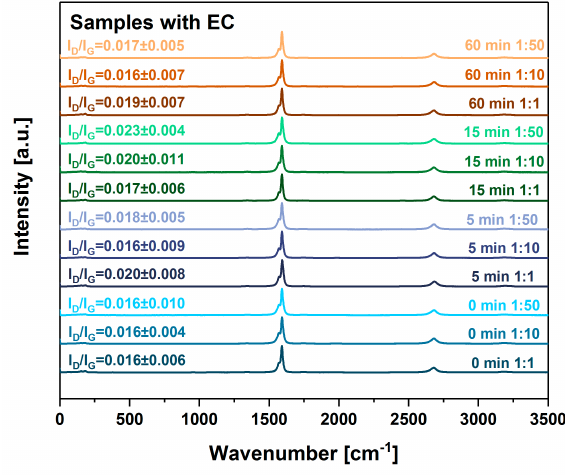
Figure 4. The influence of grinding time and EC content on crystallinity of CNT films with the binder as gauged by Raman spectroscopy.